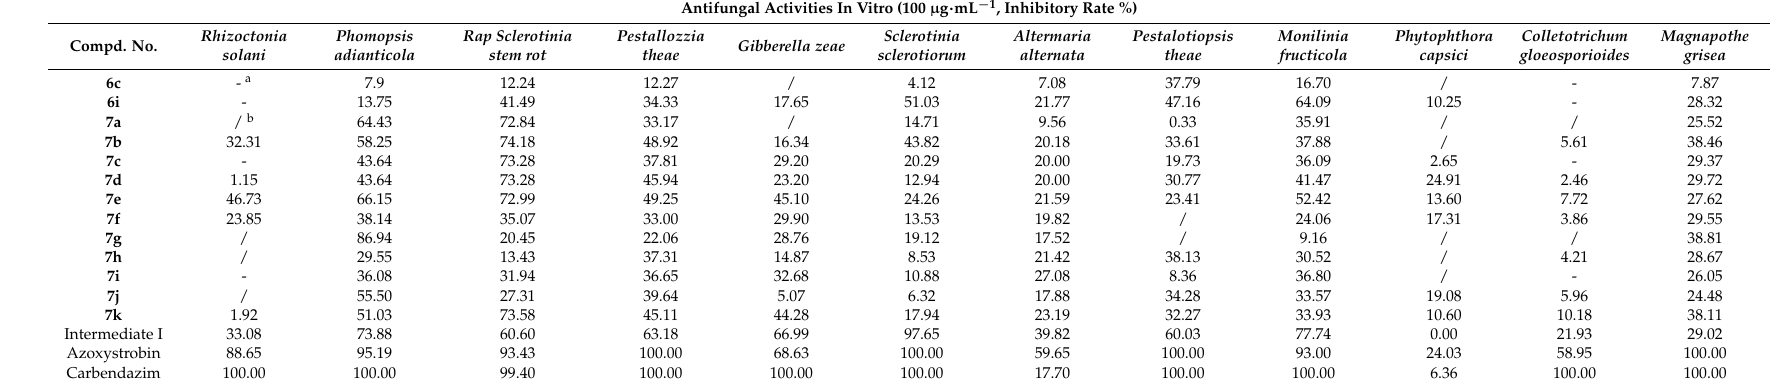
Table 1. Preliminary inhibitory effect of target compounds and intermediates on twelve common plant pathogenic fungi (100 mg · L − 1